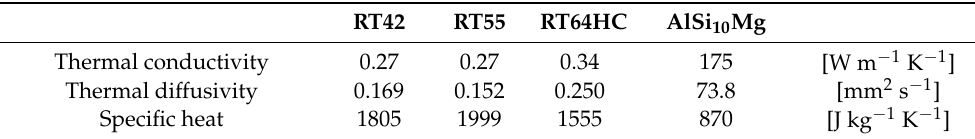
Table 2. Measured characteristics of the tested paraffins and of AlSi 10 Mg.